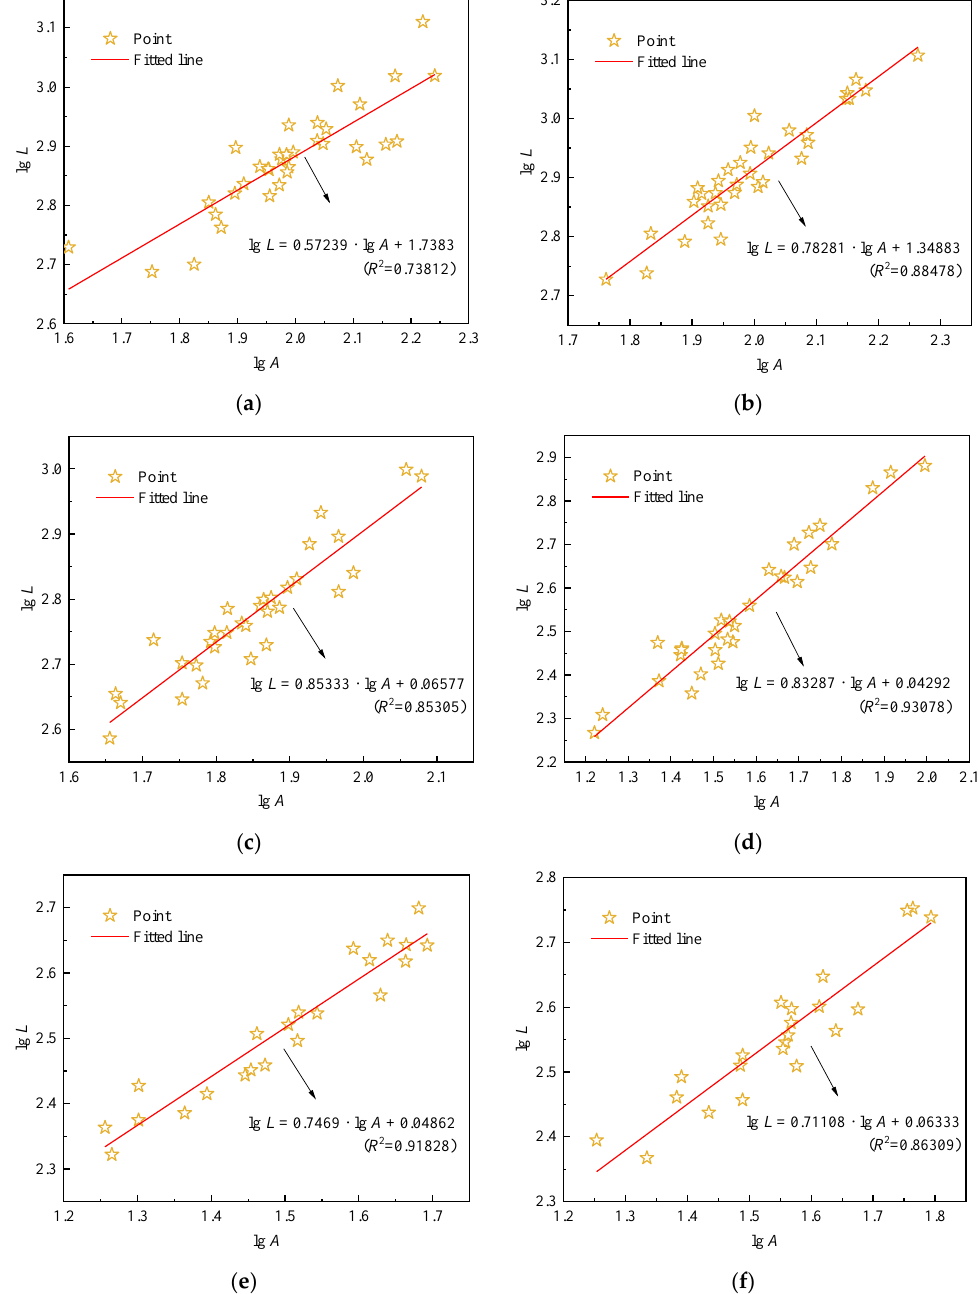
Figure 11. Fitted curves of the fractal dimension of each experimental group under different consolidation times: ( a ) 0 min; ( b ) 30 min; ( c ) 60 min; ( d ) 240 min; ( e ) 720 min; ( f ) 1440 min.